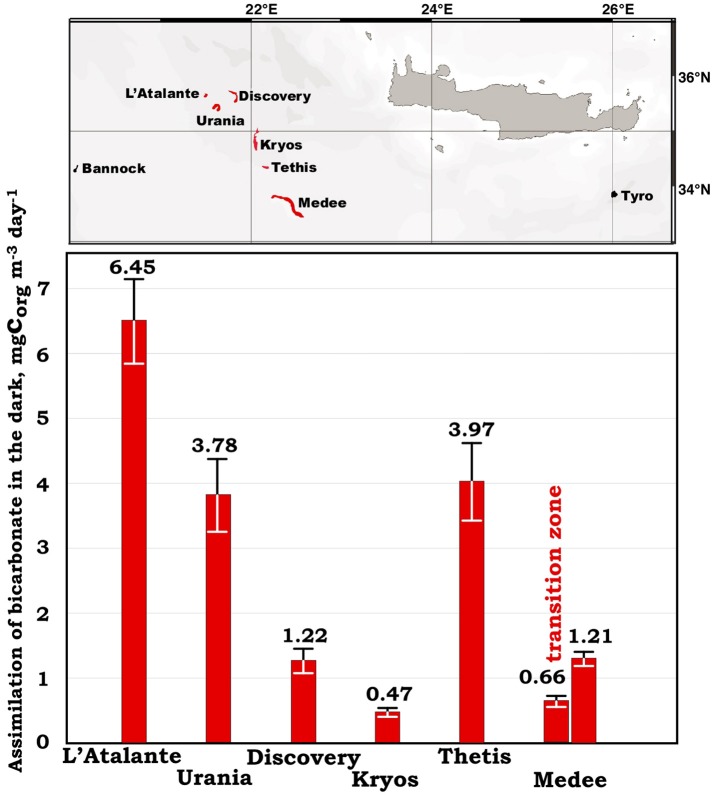
Location of all currently known Mediterraneran DHAL and dark primary production (ABD) rates, measured in oxic/anoxic surficial layer of these deep-sea lakes.